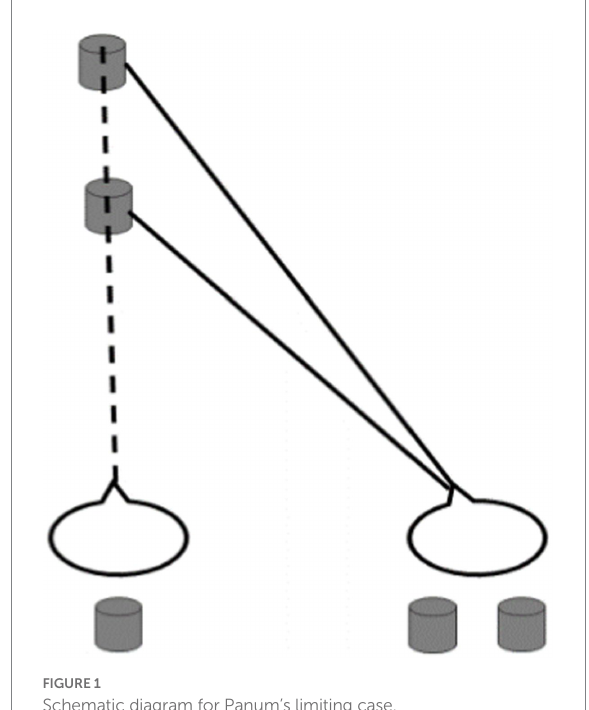
FIGURE 1 Schematic diagram for Panum’s limiting